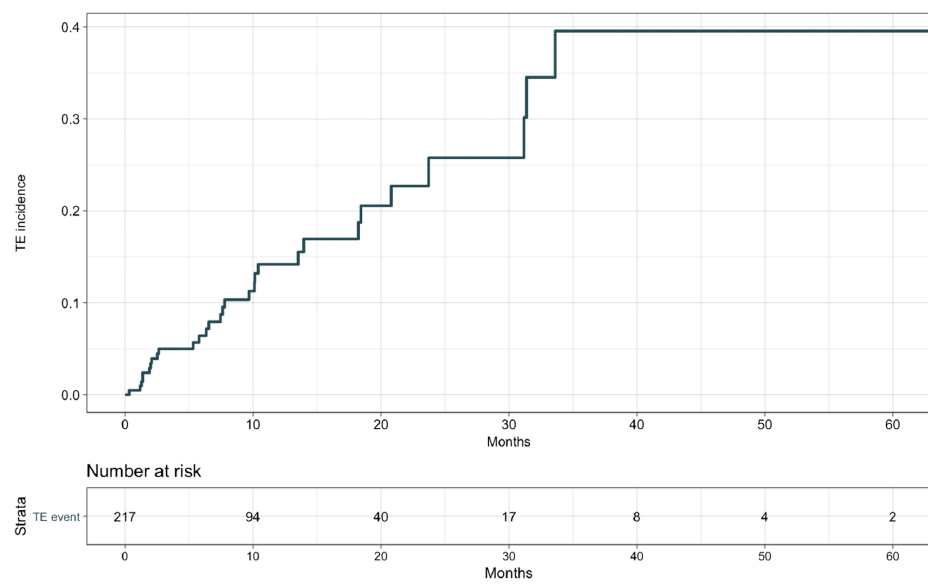
Figure 1. Thromboembolic events’ cumulative incidence.